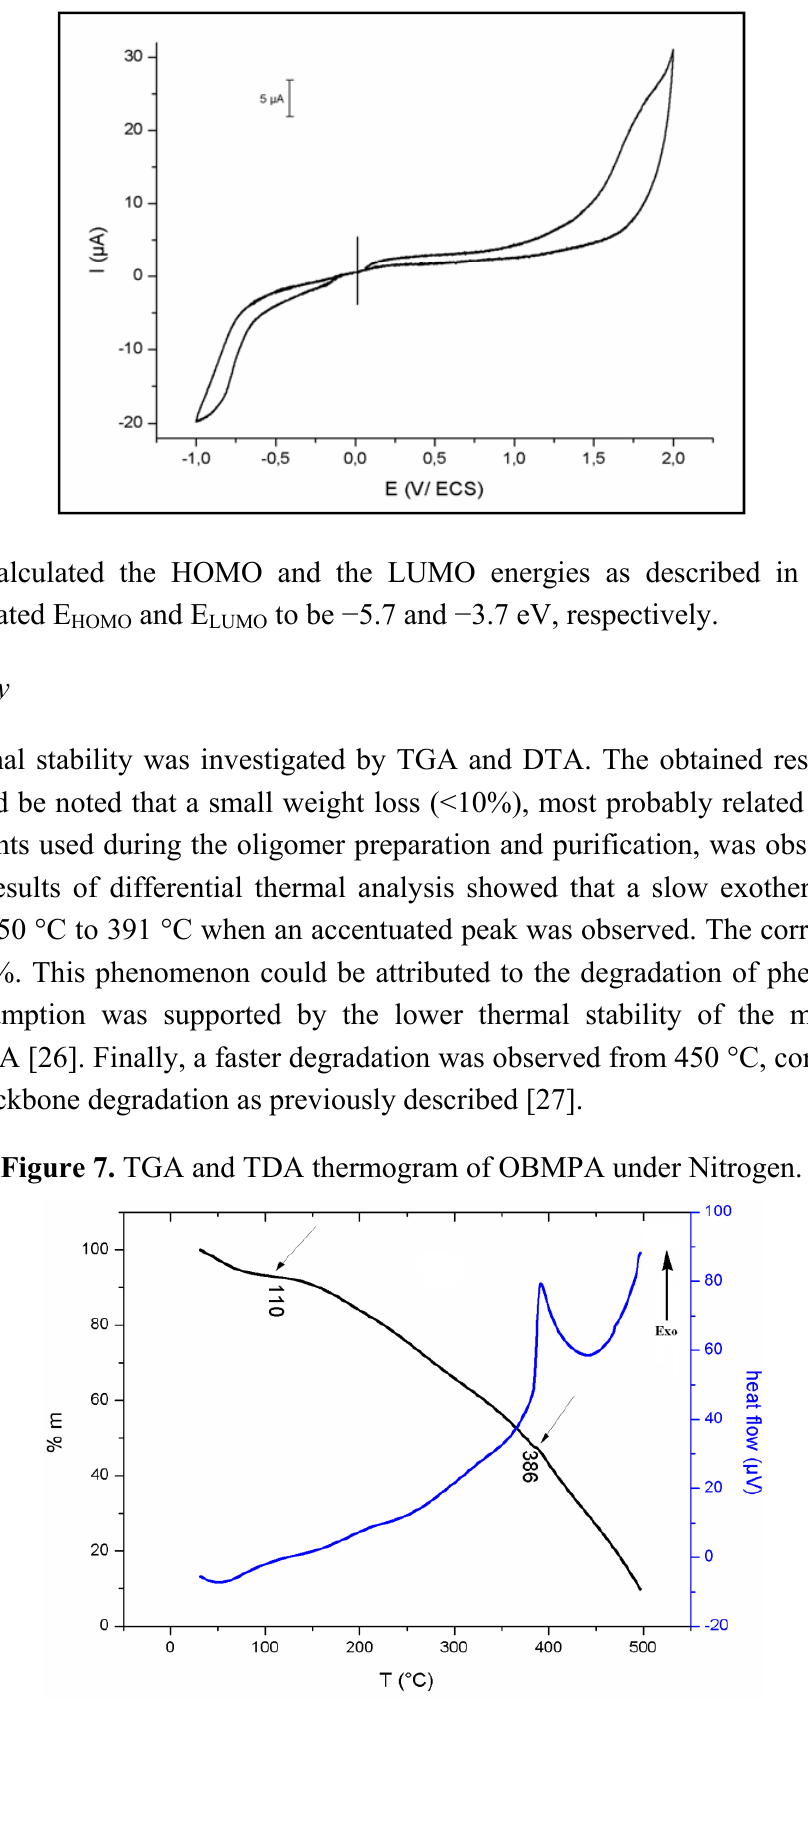
Figure 6. Oxidation and reduction voltammogram of OBMPA performed in acetonitrile,